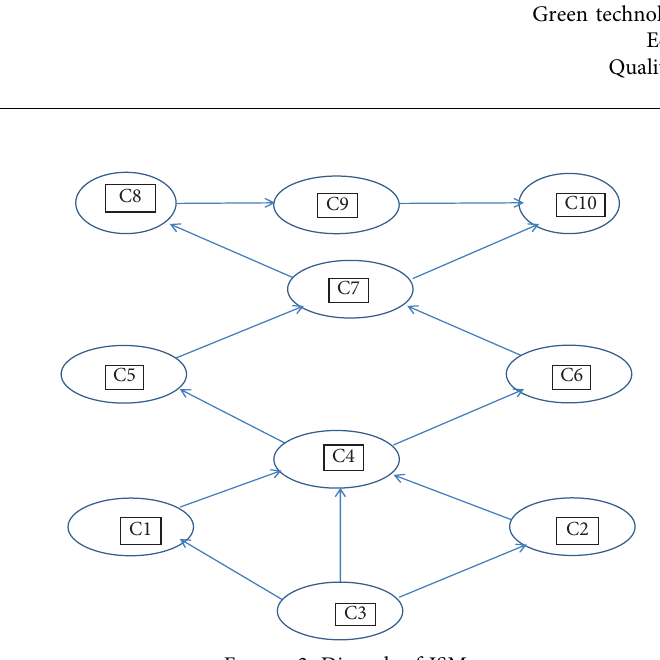
Figure 2: Digraph of ISM.